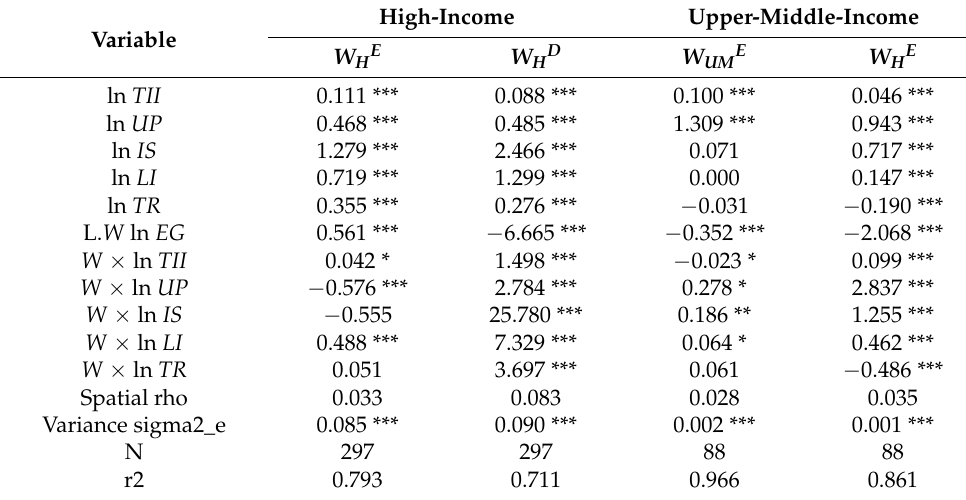
Table 9. The estimated results of robustness test based on shortening the time window. High-Income Variable